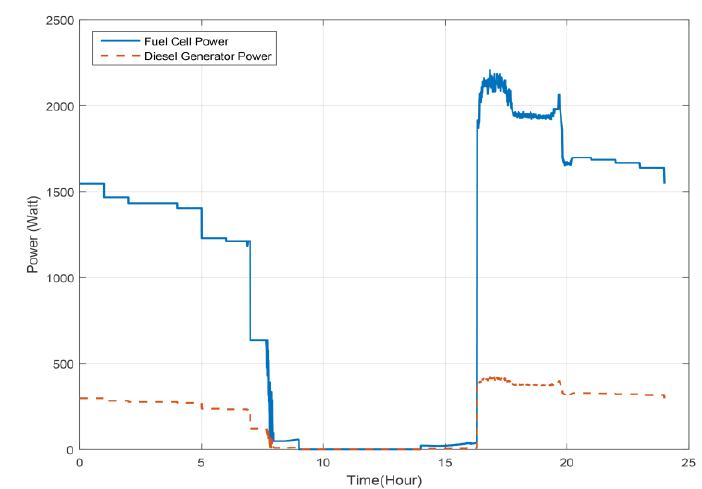
Figure 19. Operation of the fuel cell and a diesel generator in the microgrid on July 28th, 2016 controlled by optimized FLEMS considering economic dispatch using PSO.